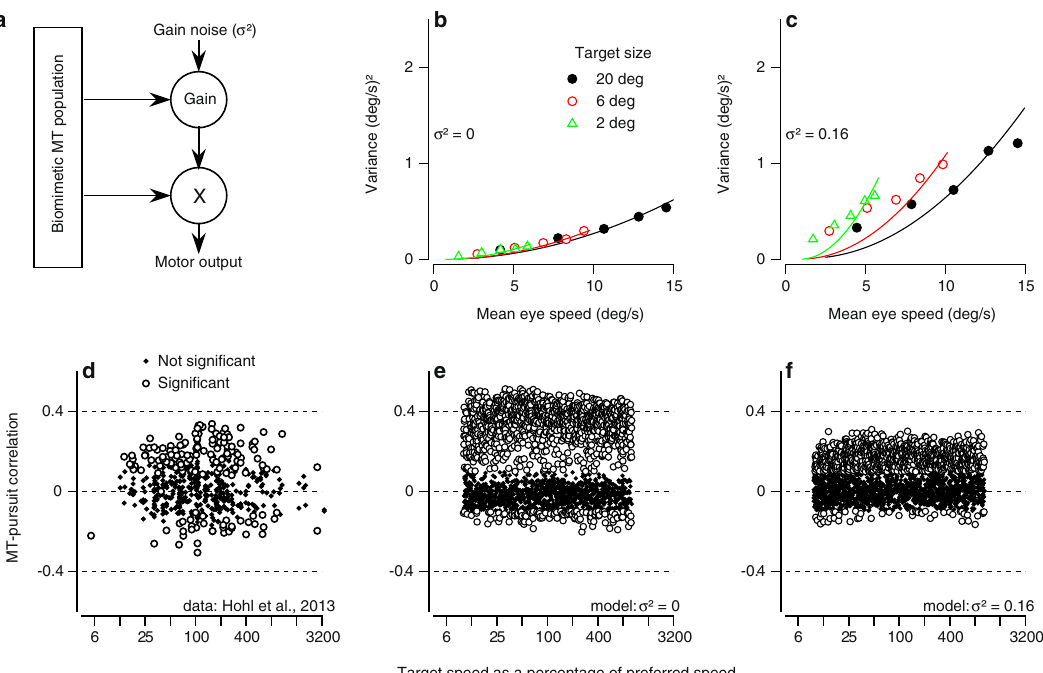
Fig. 5 Biomimetic model with gain noise captures key features of behavioral and neurophysiological data. a Biomimetic model as in Fig. 4a, but highlighting noise added to the gain pathway downstream of middle temporal (MT) neurons. Noise was drawn from a zero-mean Gaussian with variance σ 2 . b Relationship between variance and mean eye speed of model output without gain noise. Green triangles, red circles, and black circles correspond to model behavior in response to 2, 6, and 20 deg targets, respectively. Green, red, and black curves plot fi ts of the gain-noise model from Eq. (1) to circuit model responses to 2, 6, and 20 deg targets, respectively. c As in panel b , but with gain noise. d Observed MT-pursuit correlations, reproduced from Holh et al. 24 . Each symbol plots the trial-by-trial neuron-behavior correlation for an individual neuron. Open circles indicate statistically signi fi cant correlations ( p < 0.05). e MT-pursuit correlations measured for the model neurons in the biomimetic model without gain noise when the patch size was 20 deg. Conventions as in d . f As in panel e , but with gain noise. Note that for both the data and the model, the points in d – f with values of MT-pursuit correlation less than zero came almost entirely from neurons whose null direction was aligned with the direction of target motion. Source data are provided as a Source Data fi